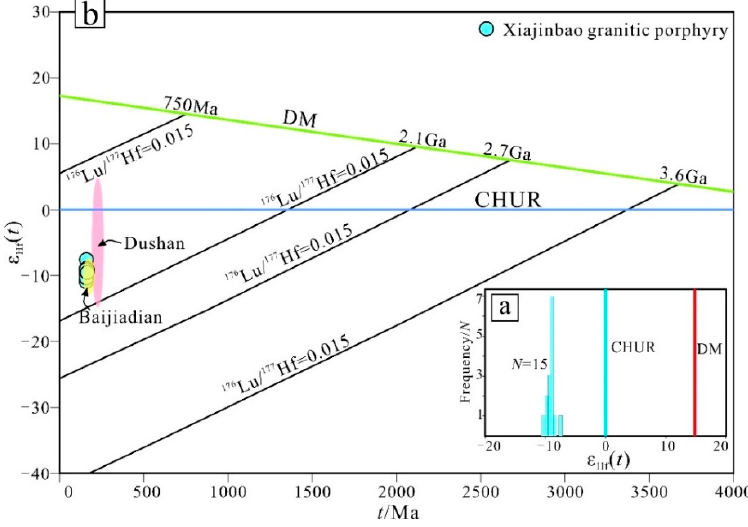
Figure 13. Histogram of ε Hf(t) ( a ) and diagram of ε Hf(t) versus U–Pb age ( b ) for zircons from the granitic rocks. The data from the Baijiadian and Dushan granites are from Xu et al. [39].